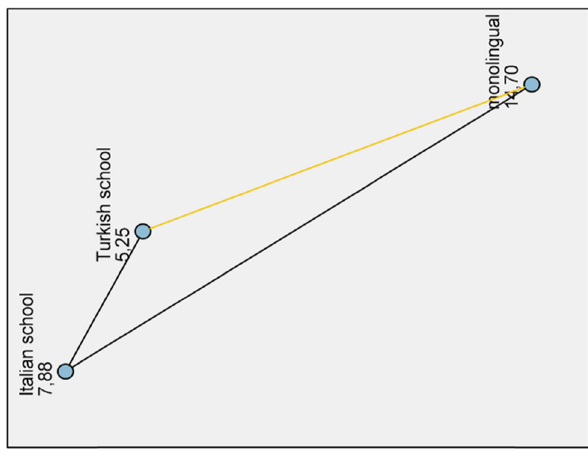
Figure 2: The results of pairwise post hoc tests for the school